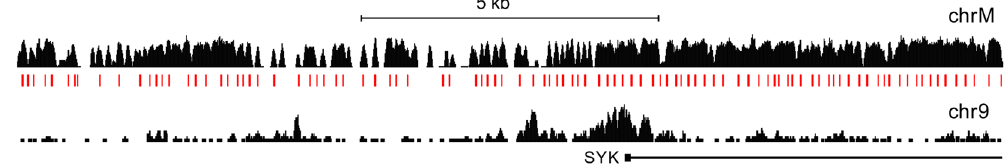
Figure 1. ATAC-seq read densities in the mitochondrial chromosome and one nuclear genome region. Top: The mitochondrial chromosome (chrM) is densely covered by uniquely mapped reads. Genomic location of the 100 mitochondrial guide RNAs (red tick marks) designed to target the human mitochondrial chromosome (top). Bottom: compare chrM to a 16.5 kb region of the nuclear genome (hg38, chr9:90,791,567–90,808,137). The chrM and chr9 tracks are shown in different height scales for easier visualization. Seven samples were pooled and 227 M reads were